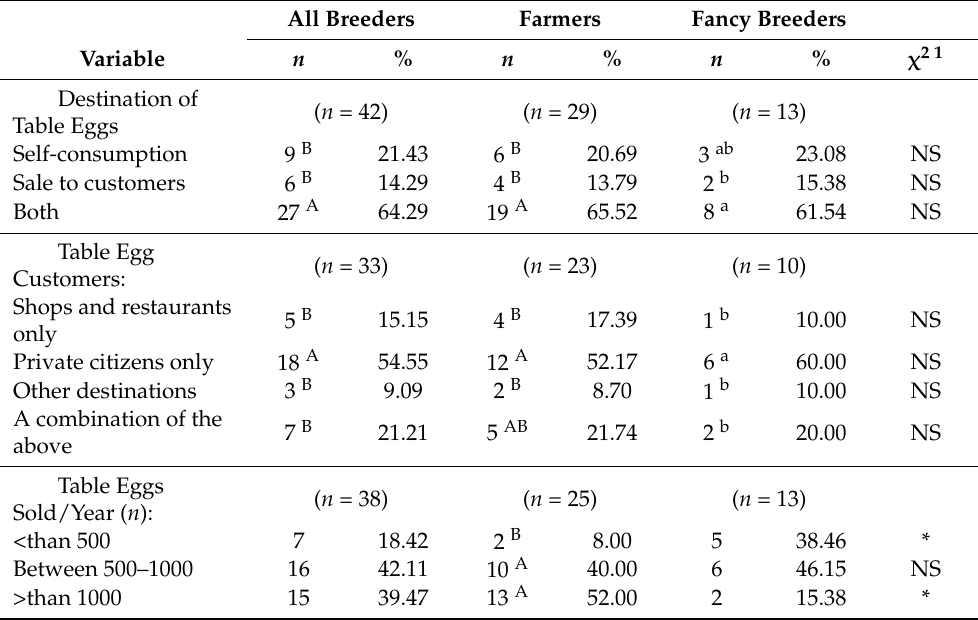
Table 5. Destination markets of Italian chicken breed table eggs: responses from all breeders and divided according to breeder category.